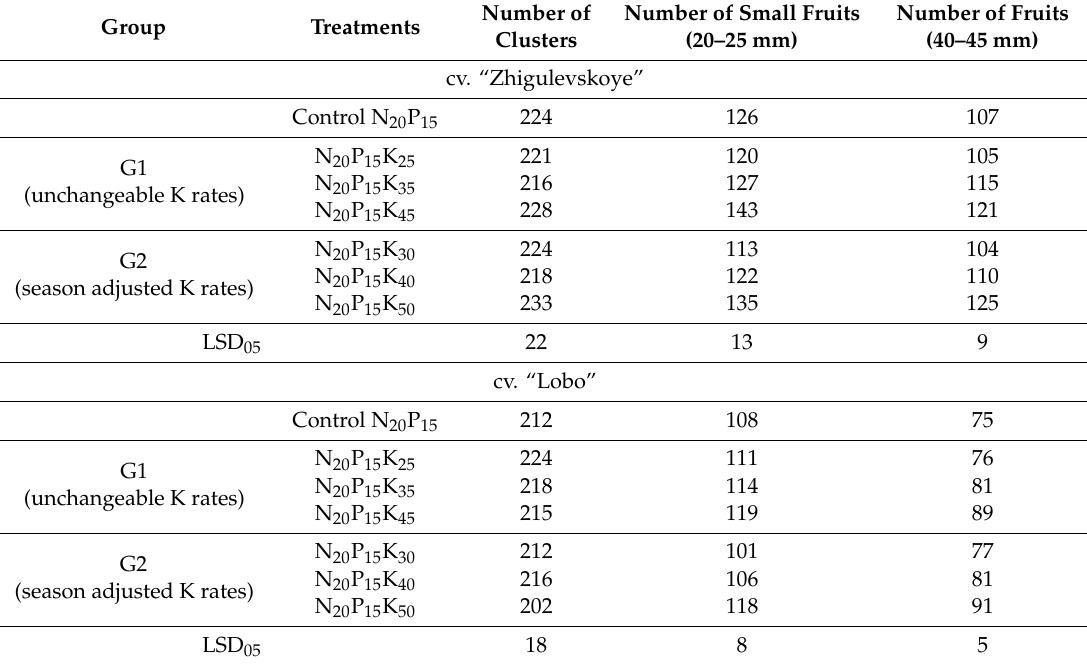
Table 7. Development of productivity components under the e ff ect of various rates of potassium fertilization and fertigation approaches in